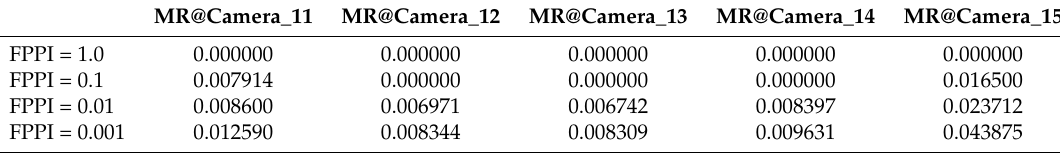
Table 14. Accuracy table @ Cameras_11–15, informed-filters, some viewpoints.